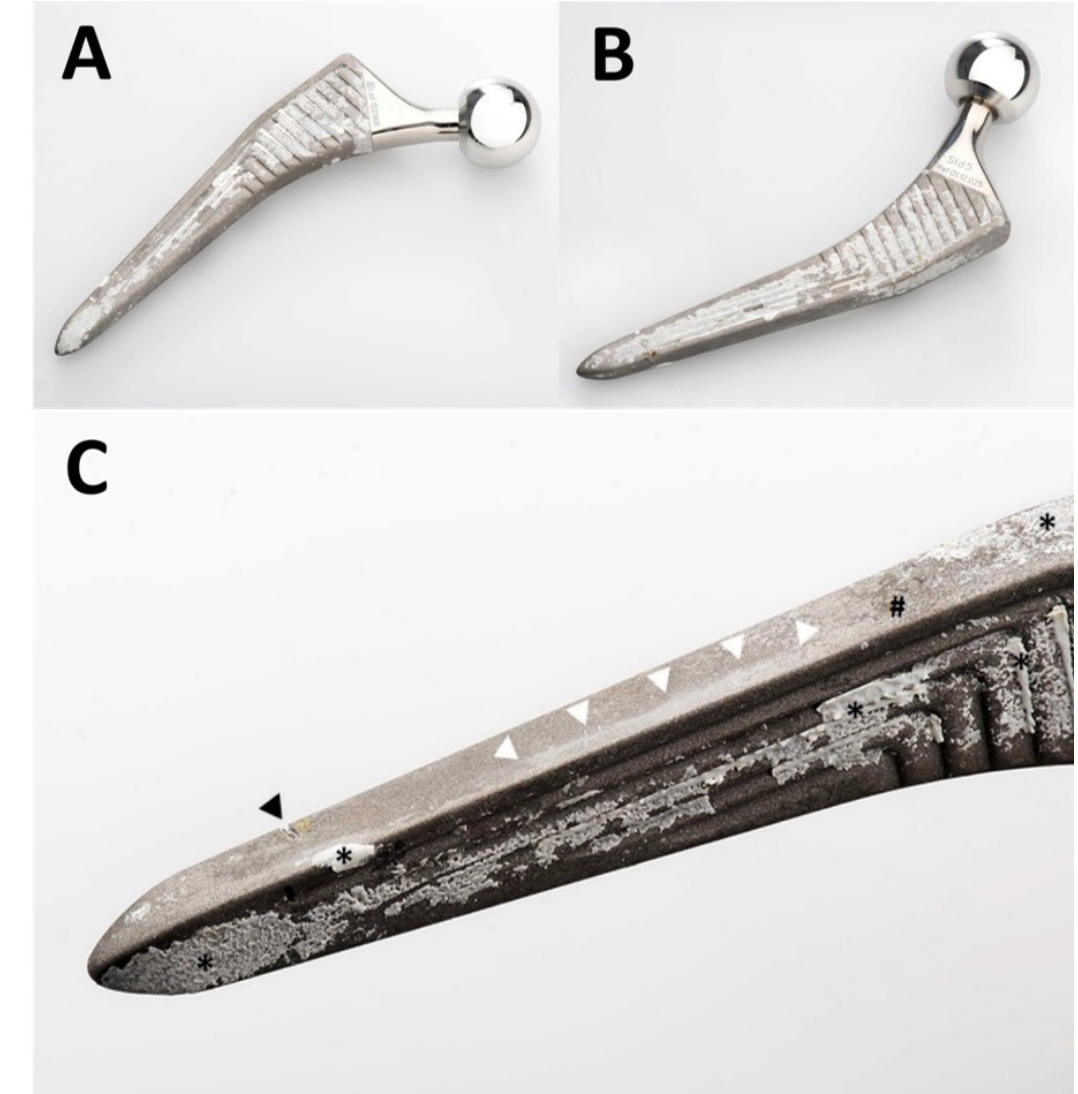
Figure 2. Photographs of the retrieved Quadra-H stem. An overview of the anterior aspect is shown in ( A ) and of the posterior aspect in ( B ). A greater magnification of the anterolateral aspect of the distal part of the stem is shown in ( C ). The femur had already fractured, and the stem could be retrieved without any instrumentation. The transverse nick near the tip (black arrowhead in ( C )) was caused by the transverse osteotomy of the transfemoral approach. This was the only damage caused by instruments. Note unevenly distributed patches of ongrown bone on the stem’s surface (* in ( C )). Only small patches of residues of the HA coating (# in ( C )) are visible. The near edge of the stem presents an extensive area of polishing (white arrowheads in ( C )) of the grit-blasted surface of the metal